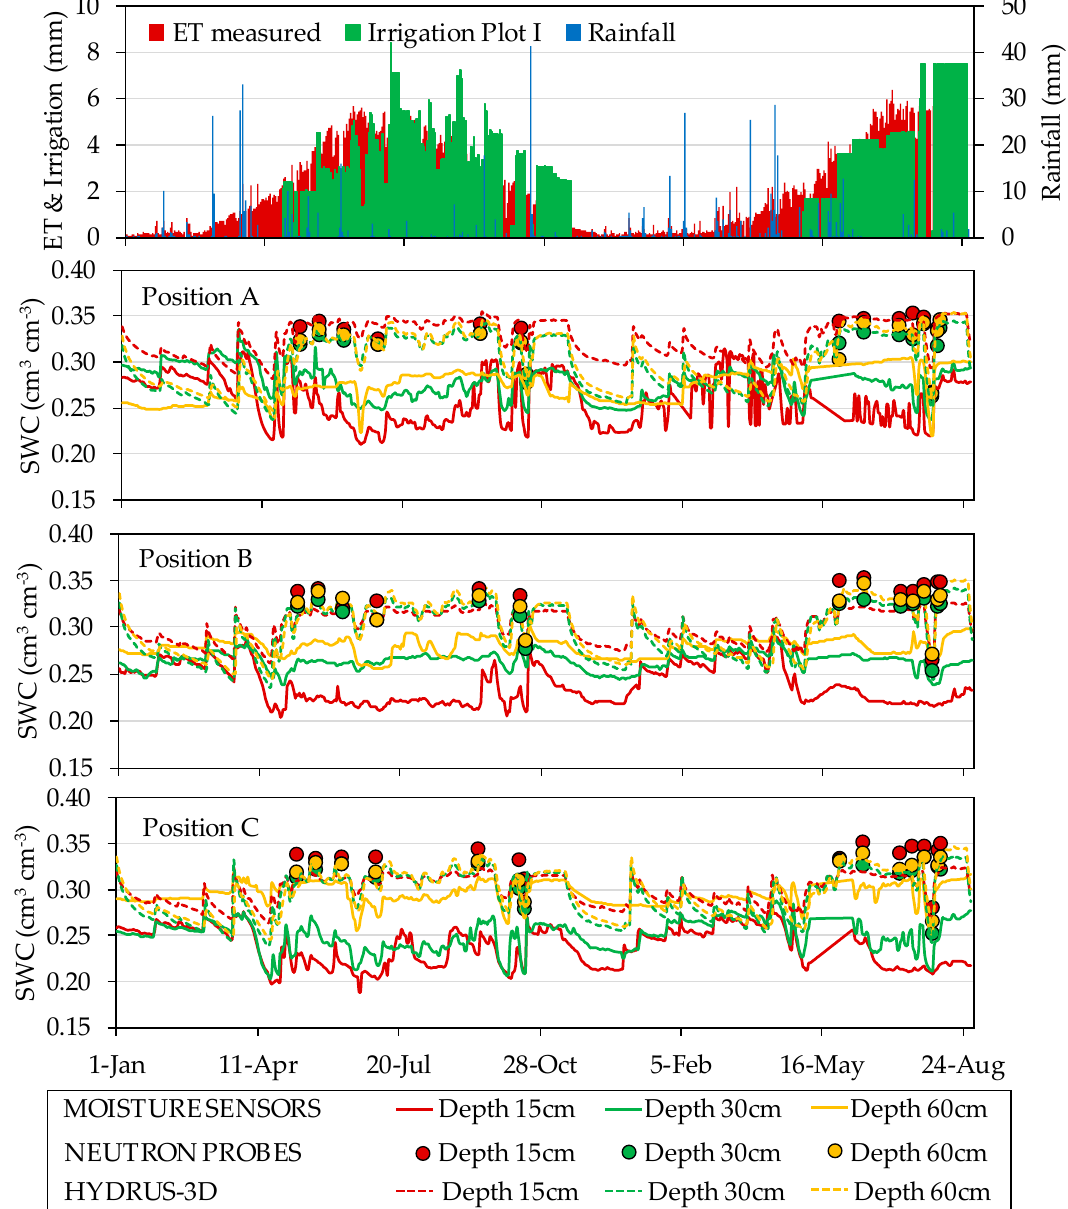
Figure 11. Seasonal variations in soil water content (represented by the series of daily minimum values, cm 3 cm − 3 ) measured by EC-5 capacitance soil moisture sensors, neutron probes and HYDRUS-3D simulations in different positions and depths in the years 2017 and 2018 in Plot I. Irrigation, rainfall, and ET measured by the weighing lysimeter is detailed at the top of the figure.